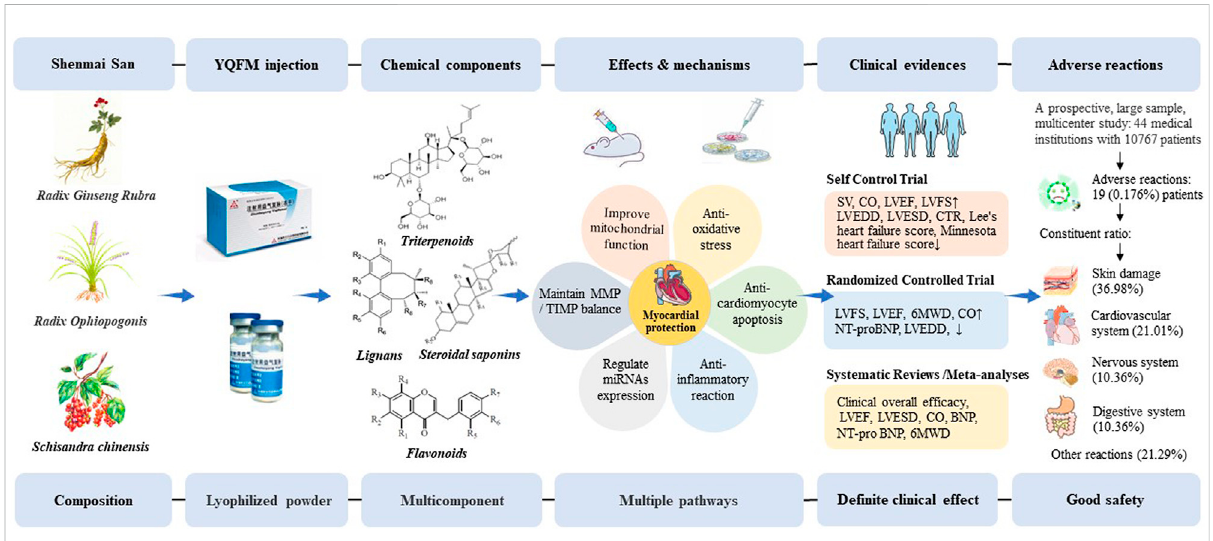
The process of YQFM in treating heart failure. BNP, brain natriuretic peptide; CO, cardiac output; CTR, calcitonin receptor; LVEDD, left ventricular end-diastolic diameter; LVEF, left ventricular ejection fraction; LVESD, left ventricular end-systolic diameter; LVFS, left